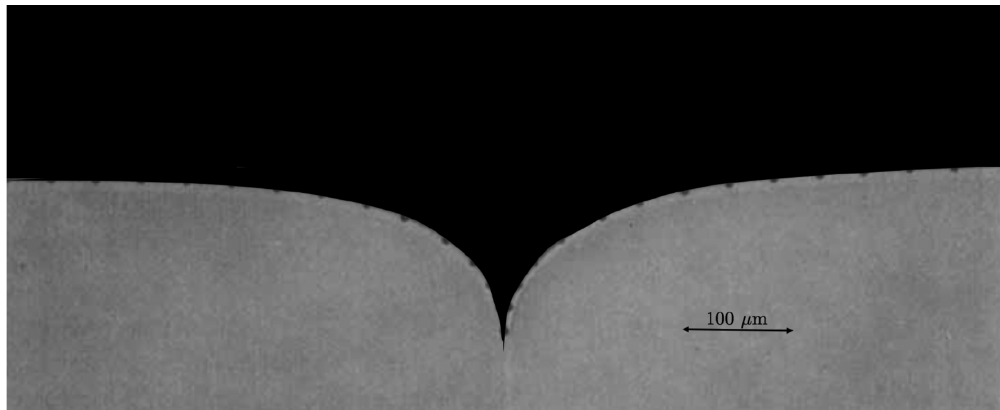
Figure 1. Photomicrograph of a stationary grain boundary groove in ultra-pure (7–9s+) [2,3] succinonitrile, a body-centered cubic organic crystal [4,5]. The black area is melt phase, and gray areas are crystallites separated by a vertical grain boundary. This equilibrated groove was photographed in situ in a steady thermal gradient of 4.0 K/m. The material’s melting point, 58.082 ± 0.001 C [2], is realized along the outer flat regions of the groove’s profile. The solid–liquid–grain boundary triple junction is located about 150 microns below the flatter regions, surrounded by a sharp cusp of melt undercooled less than 1 mK. Points added along the solid–liquid interface were analyzed in a prior study to estimate the solid–liquid interface energy along a grain boundary groove equilibrated under various thermal gradients. Micrograph adapted from reference